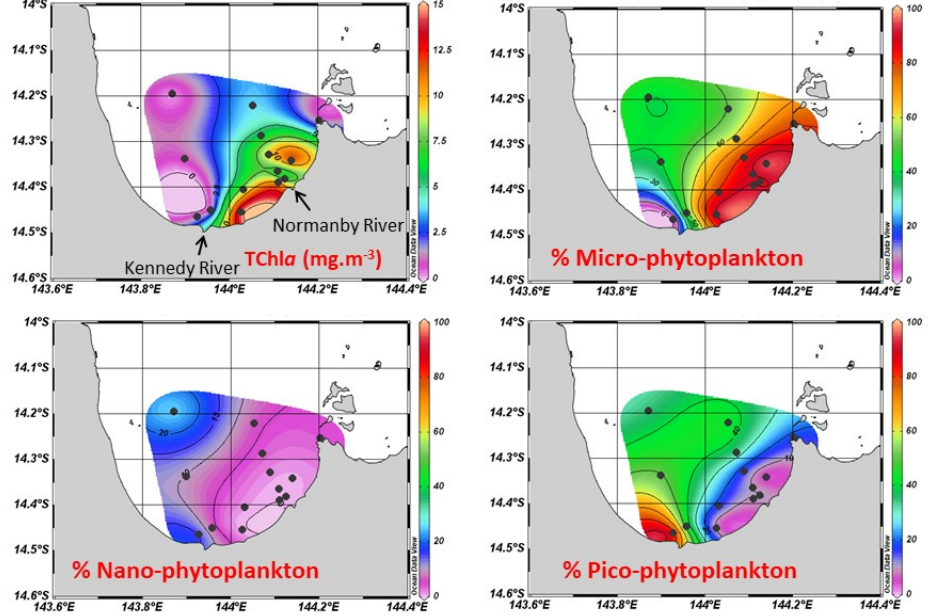
Figure 8. Spatial distribution of TChl a , the relative contribution (0–100%) of the different size fractions to phytoplankton: microphytoplankton (>20 μ m), nanophytoplankton (2–20 μ m), and picophytoplankton (<2 μ m) in the surface layer.